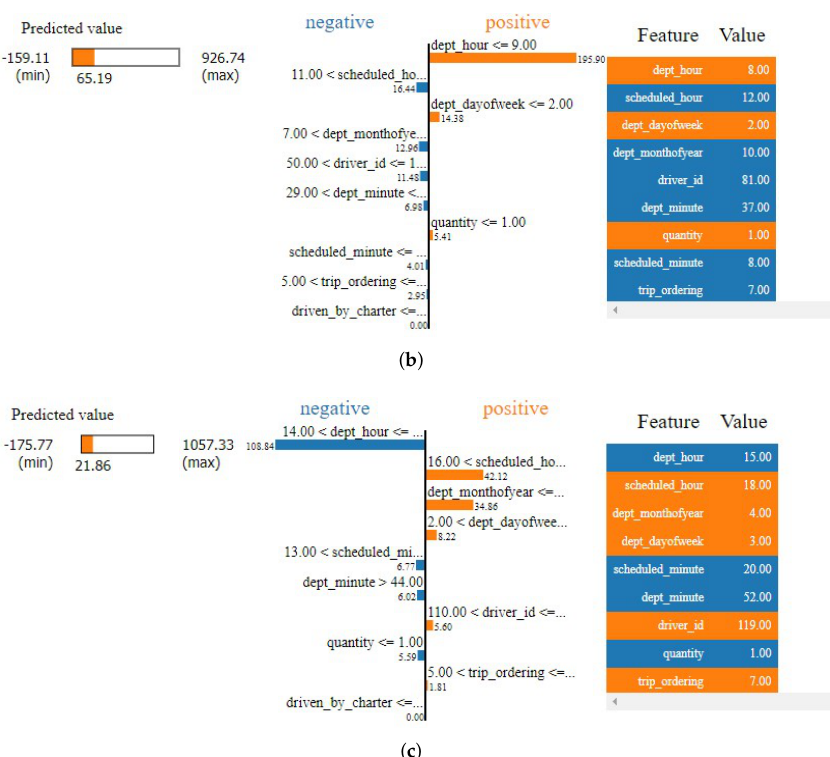
Figure 8. LIME feature Contribution Plots for Explaining Three Prediction Instances. ( a ) Instance-1. ( b ) Instance-2. ( c )